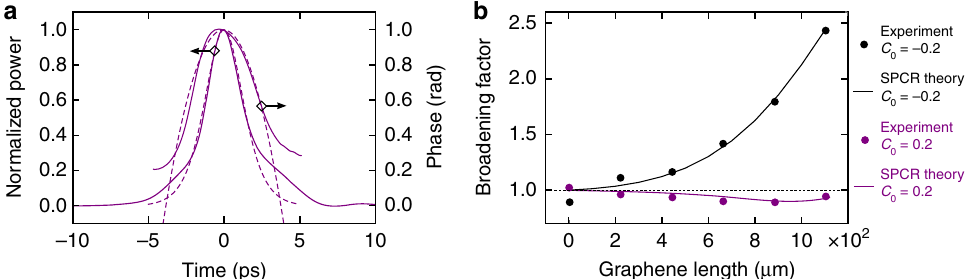
Fig. 3 Characteristics of positively chirped input pulses and corresponding broadening results. a Temporal power pro fi le and phase pro fi le of the positively chirped input pulse p2 measured with the frequency-resolved optical gating (FROG) technique (solid curves) and the corresponding fi t assuming a ¼ 0 : 2 and T ð p2 Þ ¼ 3 ps (dashed curves). b Broadening factor for input pulse p2 with C ð p2 Þ ¼ 0 : 2 as a function of quadratic phase pro fi le with C ð p2 Þ 0 0 FWHM ; 0 graphene length (in purple). Both the experimental data points and the results from our saturable photoexcited-carrier refraction (SPCR) theory are shown. ¼ (cid:2) 0 : 2 (in black) as shown in Fig. 2a For comparison we also plot again the broadening factors for input pulse p1 with C ð p1 Þ 0